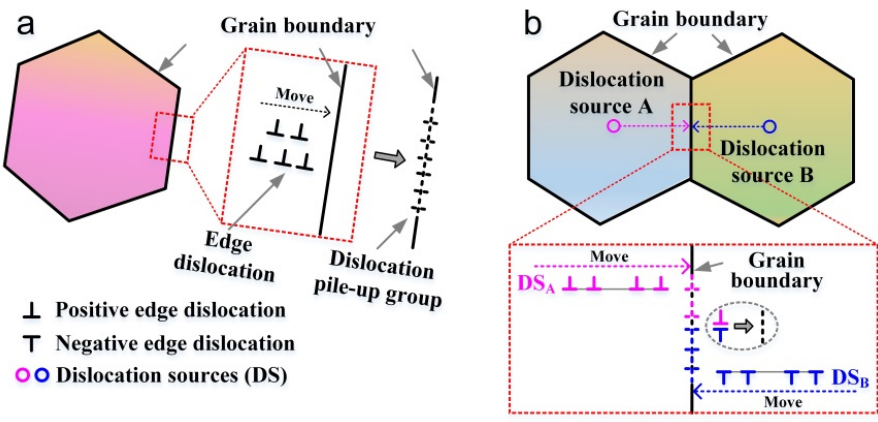
Figure 8. Schematic diagram of dislocations absorbed by the grain boundary. ( a ) Edge dislocations accumulate before the grain boundary, and may be absorbed by the grain boundary, forming disloca- tion pile-up groups. ( b ) Dislocation sources (DS A and DS B ) from the center of two adjacent grains emit edge dislocations with opposite signs, which are absorbed by the grain boundaries after their accumulation in the grain boundaries. These grain boundary dislocations with opposite signs may cancel each other